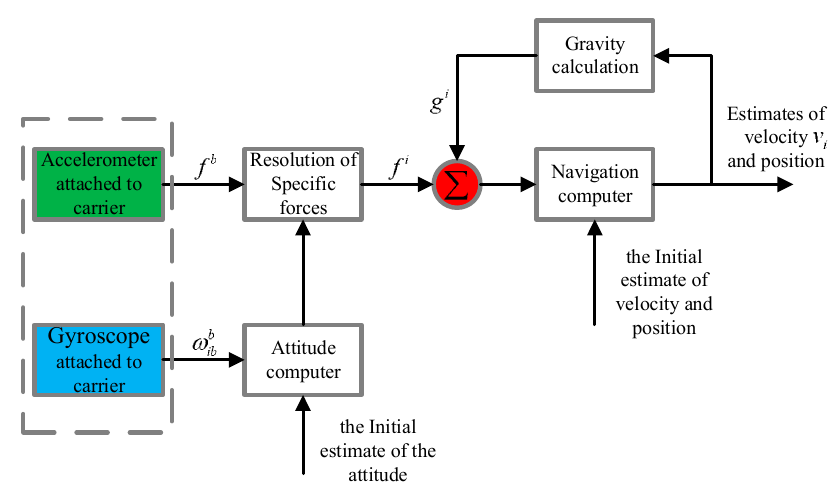
Figure 6. Arrangement of the machinery of the strapdown inertial navigation system.